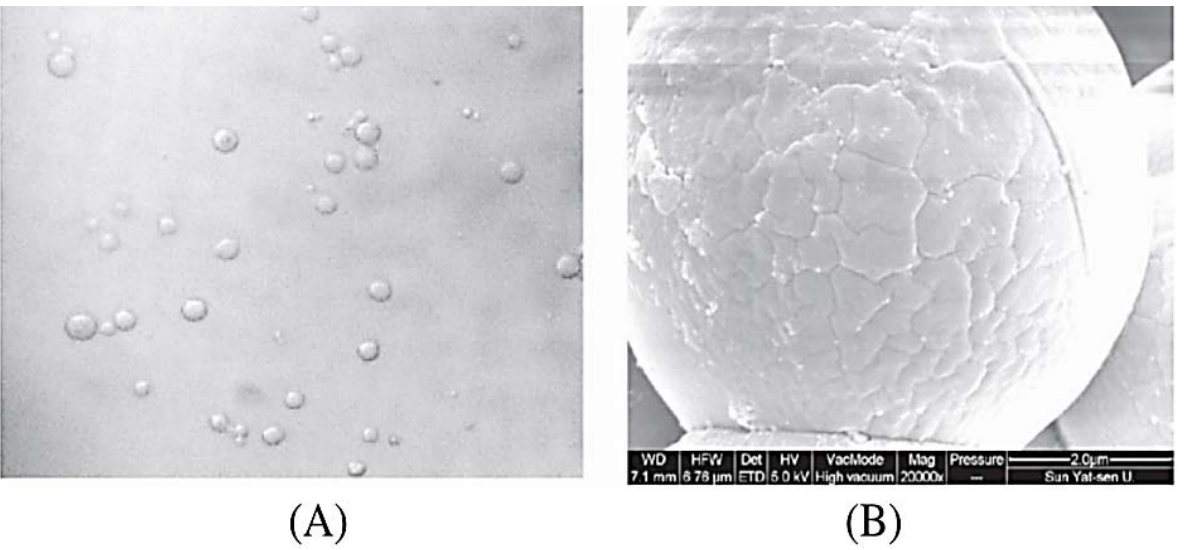
Figure 11 . SEM images of ERY gelatine microspheres: ( A ) (100×), ( B ) (20,000×). Reprinted with Figure 11. SEM images of ERY gelatine microspheres: ( A ) (100 × ), ( B ) (20,000 × ). Reprinted with permission from [19]. permission from